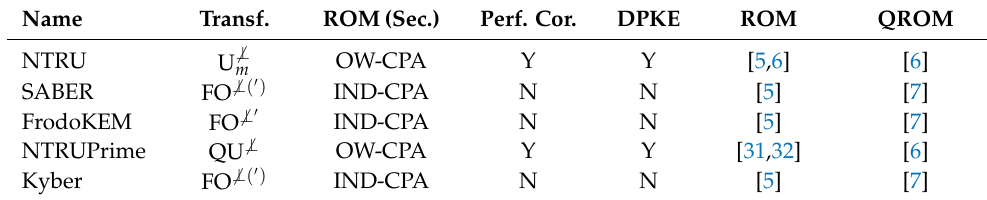
Table 6. NIST lattice-based proposals and their main